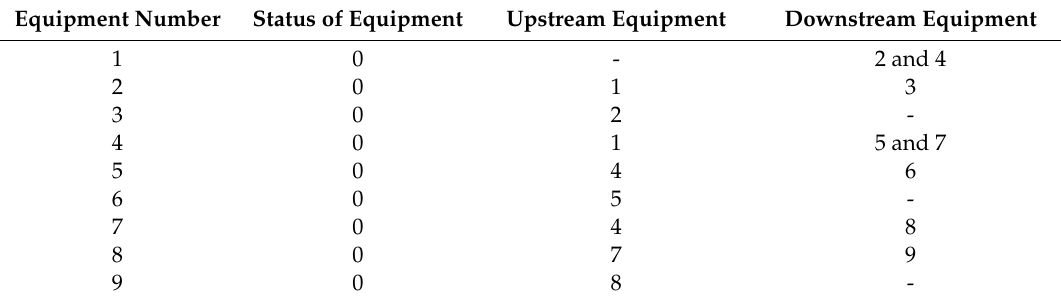
Table 1. The line list of Figure 1.